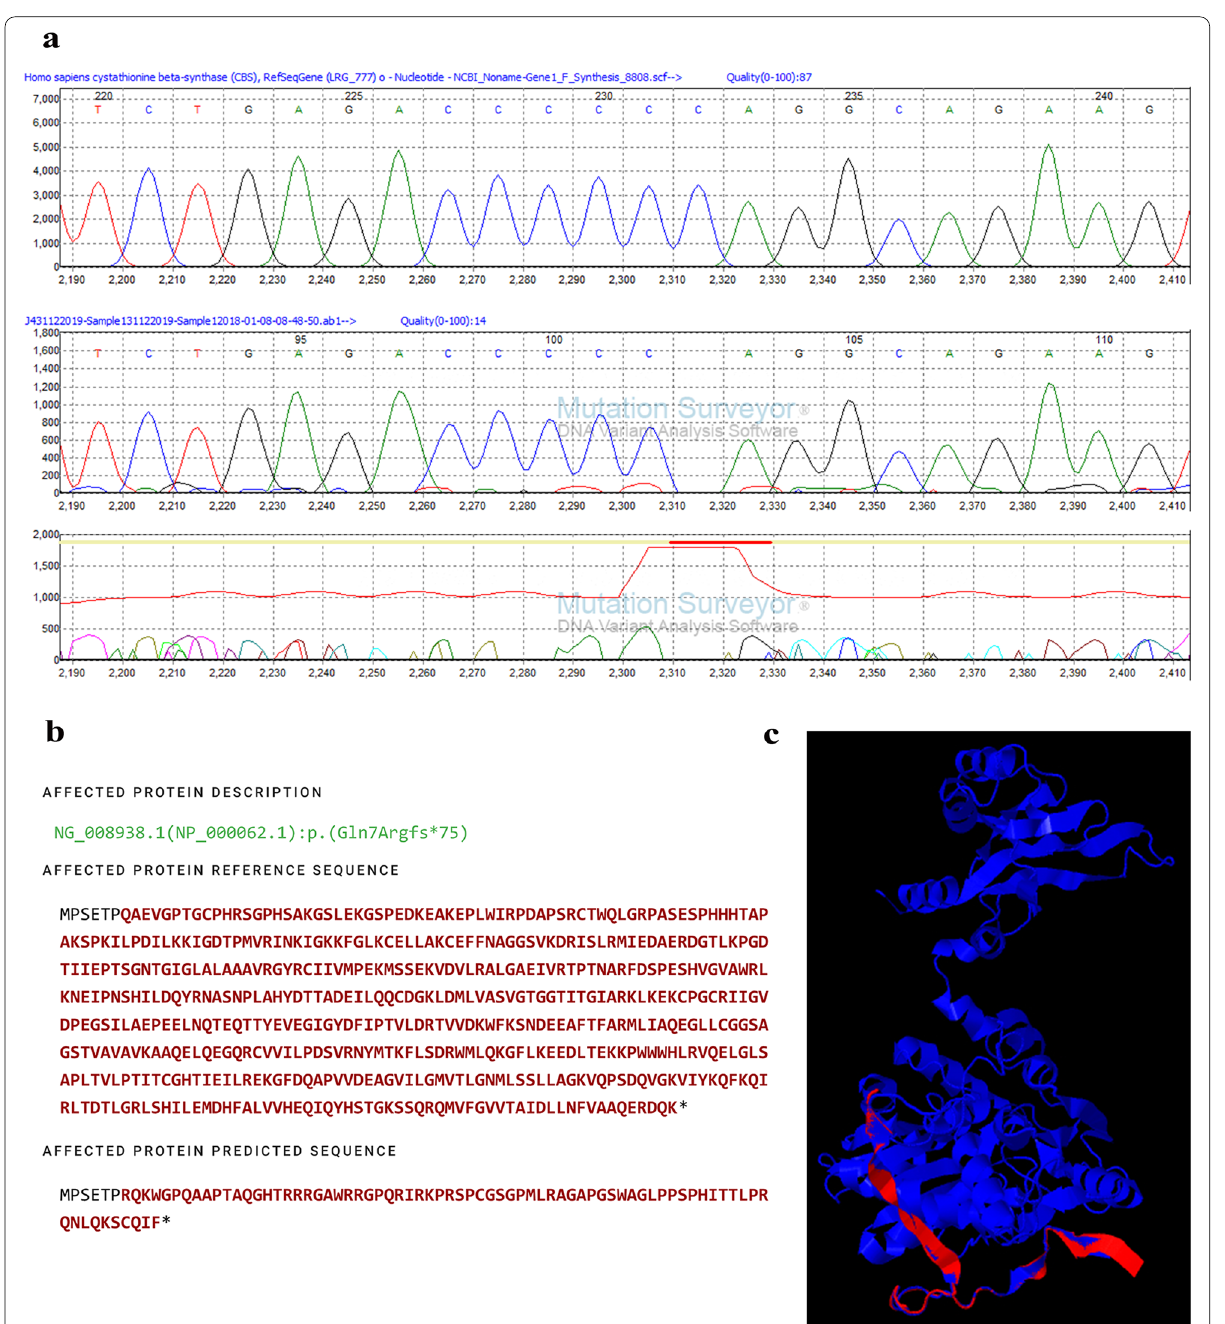
Fig. 3 Reported nonsense variant, c.19del in CBS gene (p. Gln7Argfs*75*) in exon 1. a Mutation Surveyor ® V4.0.10 images indicating the homozygous substitution point; R indicates the reference CBS sequence, and S indicates the study sample CBS sequence. b Protein prediction using Mutalyzer 3. c Superimposed image of predicted mutated protein with wild-type CBS protein (P35520 CBS_HUMAN), red indicates the mutated